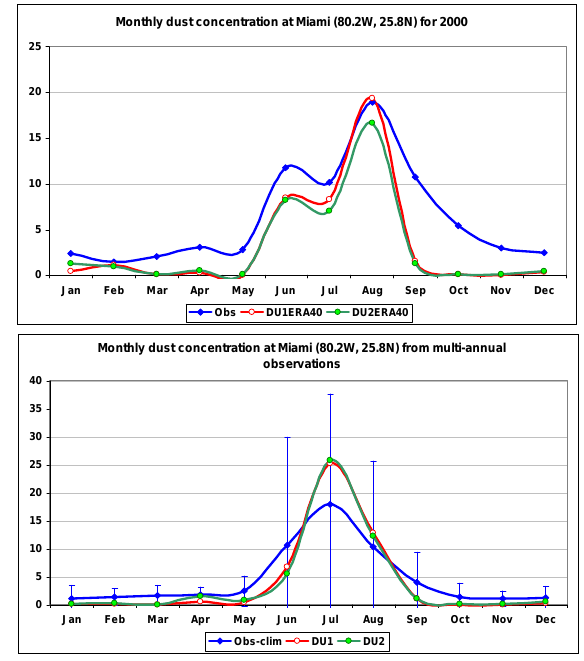
Fig. 5. Comparison of monthly modelled and measured dust con- centrations (µgm − 3 ) at the Miami station. The upper panel shows results from the nudged simulations and the lower panel from the free-running simulation. Measurements for the year 2000 are indi- cated by the blue line in the upper panel; the climatology of the sta- tion (multi-annual averages) is shown by the blue line in the lower panel including the standard deviation for each monthly average. The model results from DU1 are shown in red and from DU2 in